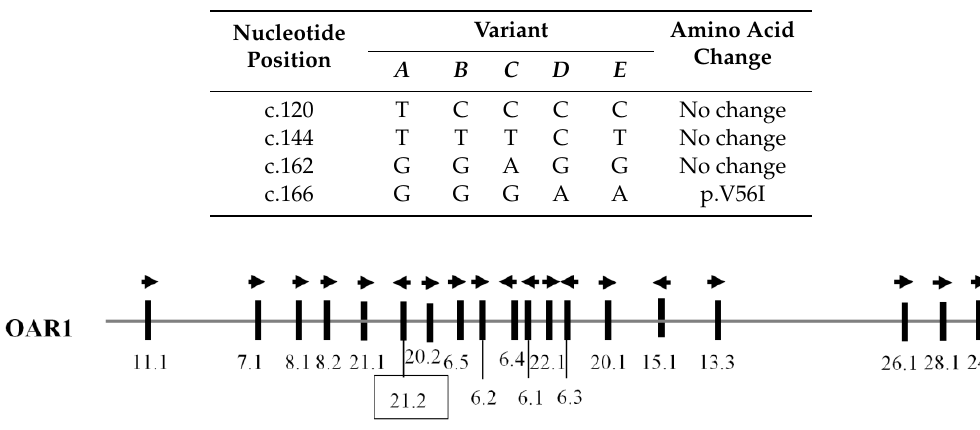
Figure 1. The chromosome 1 location of KRTAPs . The newly identified ovine KRTAP21-2 is shown in a box, along with eighteen previously identified KRTAPs . Vertical bars represent the location of different KRTAPs and the arrowheads indicate the direction of transcription. The numbers below the bars indicate the name of the respective KAP genes (i.e., 24.1 is KRTAP24-1 ).